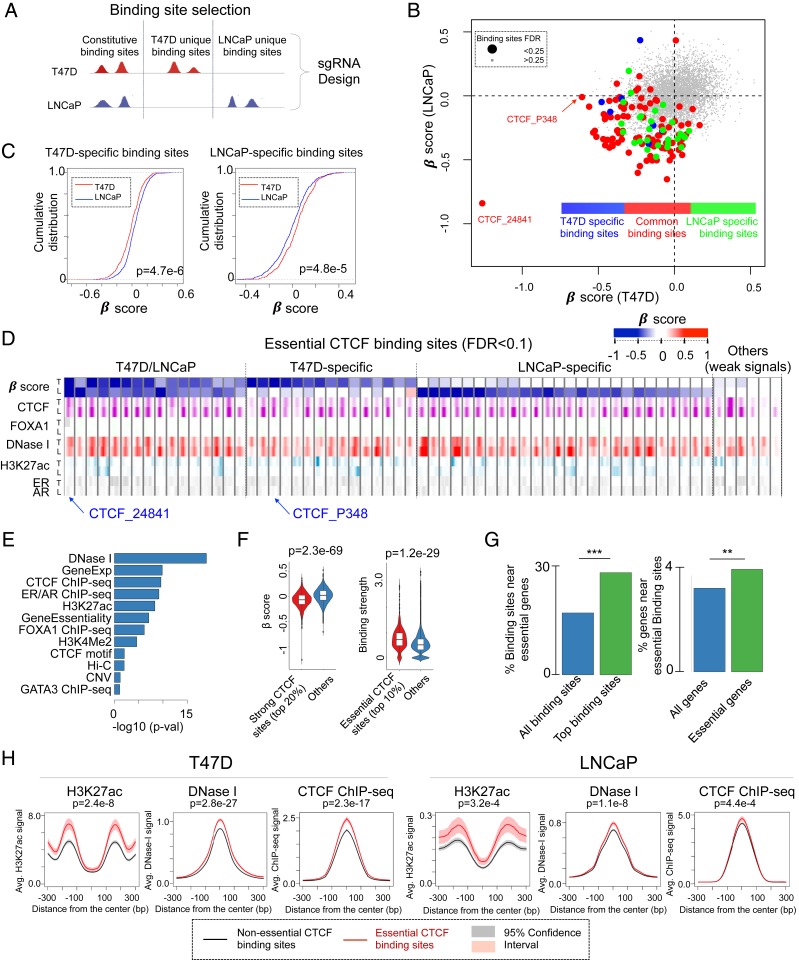
Genome-wide CRISPR screens for CTCF binding sites. (A) CTCF binding site selection procedure in screening library design. (B) The β-scores of all CTCF binding sites in T47D and LNCaP cells. Binding sites are colored by their appearances in both cell lines: Binding sites that only appear in T47D (or LNCaP) are colored in blue (or green), while common binding sites are colored in red, respectively. (C) The cumulative distribution of β-scores of T47D cell-specific and LNCaP cell-specific CTCF binding sites in T47D (red) and LNCaP (blue) cells. The P values are calculated by the Kolmogorov–Smirnov test. (D) The chromatin features of selected binding sites with statistical significance coming out of the cistrome screens. (E) The rankings of all features associated with the functions of CTCF binding sites. For each feature, we compare its signal distribution between the top 5% essential binding sites vs. other binding sites. The average of P values (calculated using the Mann–Whitney U test) across 2 cell lines is used to measure the relevance of each feature. (F) The β-score distribution of the strongest CTCF binding sites vs. others, and the binding strength of the top essential CTCF binding sites vs. other binding sites in T47D cells. (G) The percentage of all (and essential) CTCF binding sites that are within 100 kb of essential genes in T47D cells, and the percentage of all (and essential) genes near essential CTCF binding sites. Essential genes are genes with the 10% lowest β-scores from genome-wide CRISPR gene screens in T47D cells. **P < 0.01, ***P < 0.001. (H) The epigenetic features of essential binding sites vs. nonessential binding sites.